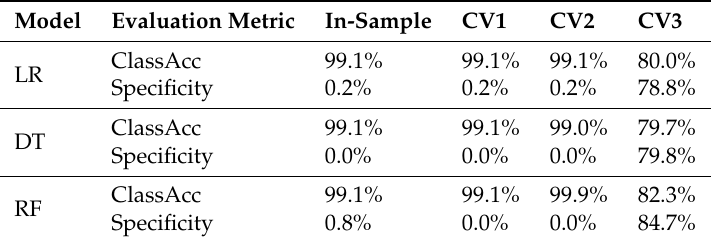
Table 7. Model evaluation results.